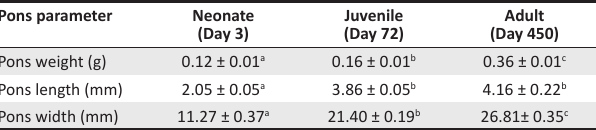
Means on the same row with different alphabet superscripts are significantly different ( p < 0.05). Means on the same row with the same alphabet superscript are not significantly different ( p > 0.05). SEM, standard error of mean.